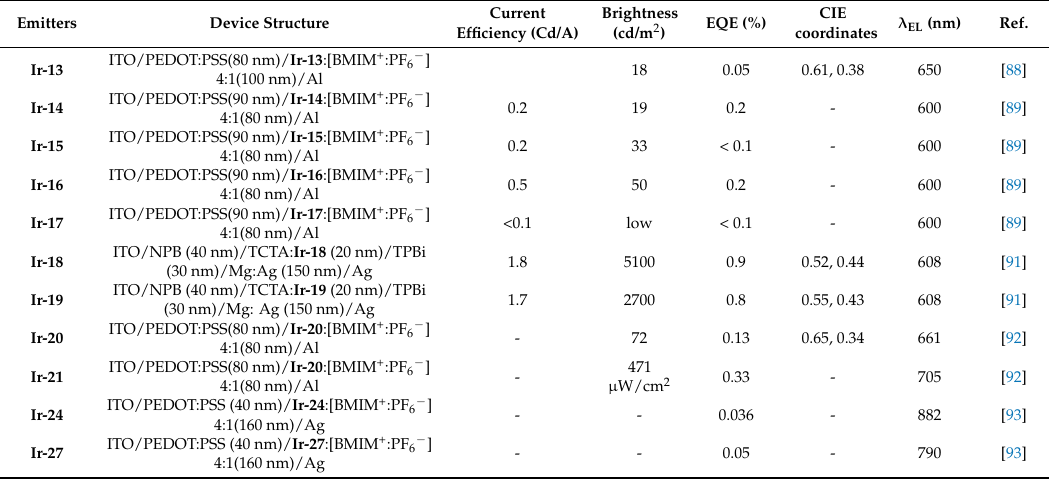
Table 3. Summary of electroluminescent properties of light-emitting electrochemical cells (LECs) and organic light-emitting diodes (OLEDs) fabricated with